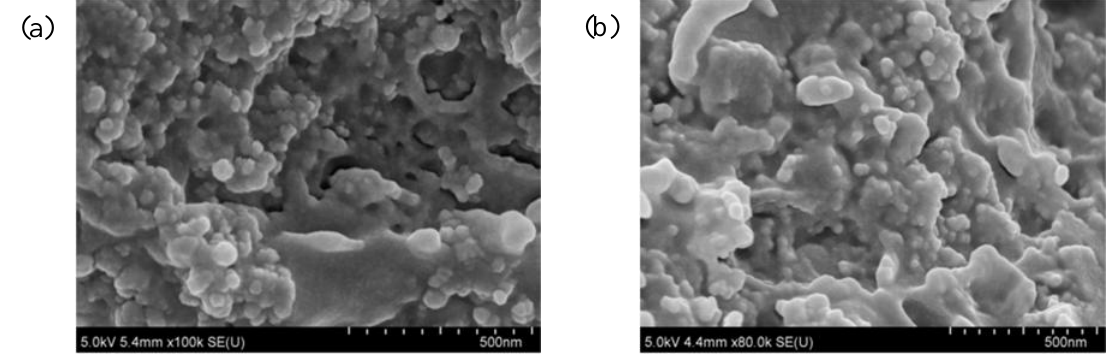
Figure 13. SEM microphotographs SEM of brittle fractures: EP with the addition of 3.0% I-HS-P3 (EPIHSP3-3.0) ( a ); and EP with the addition of 4.5% I-HS-P3(EPIHSP3) ( b